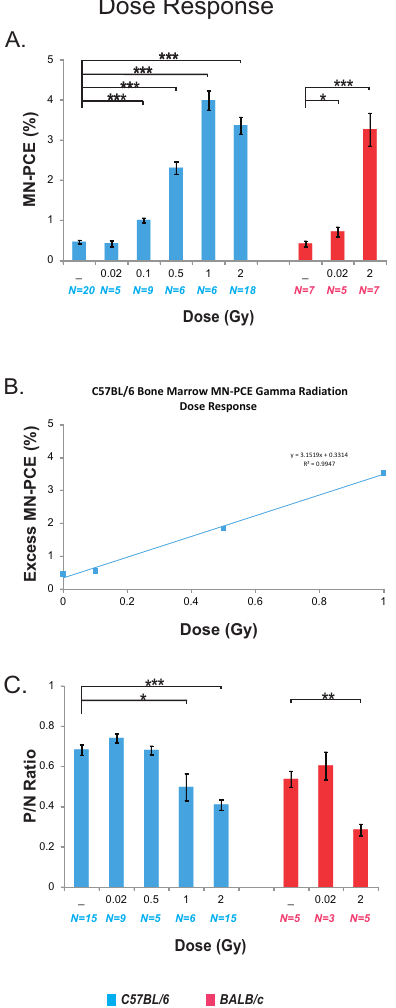
Figure 2. Dose–response for MN-PCE frequencies and polychromatic/normochromatic erythrocyte ( P / N ) ratios in mouse bone marrow. Radiation doses were delivered 24 h (1 and 2 Gy) or 28 h (20 mGy, 100 mGy and 500 mGy) prior to sacrifice. N = number of animals sampled per treatment group. Data points for C57BL/6 mice (blue columns) or BALB/c mice (red columns) represent the